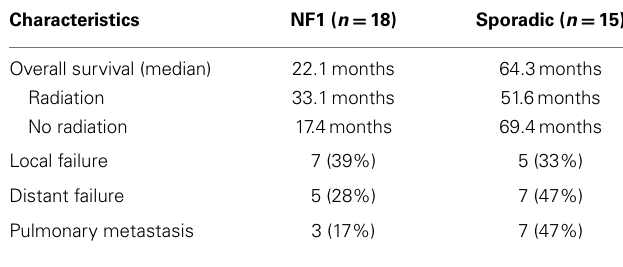
Table 3 | Survival of NF1 and sporadic MPNST .